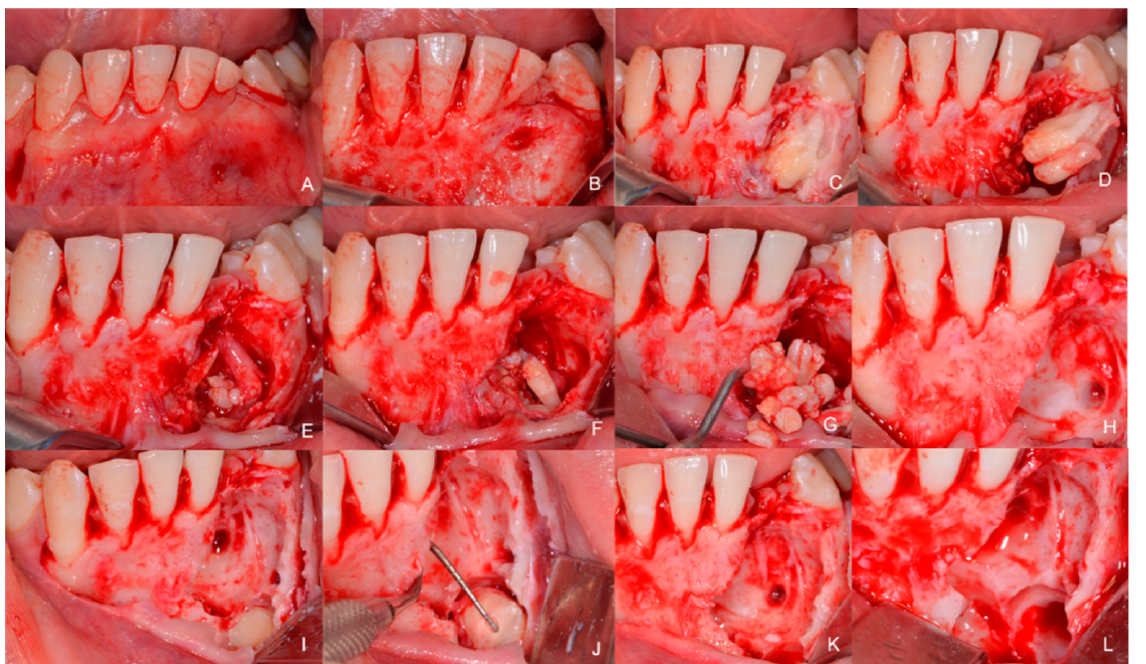
Figure 7. Intraoperative images. ( A ) “L”-shaped flap with the first incision with a distal